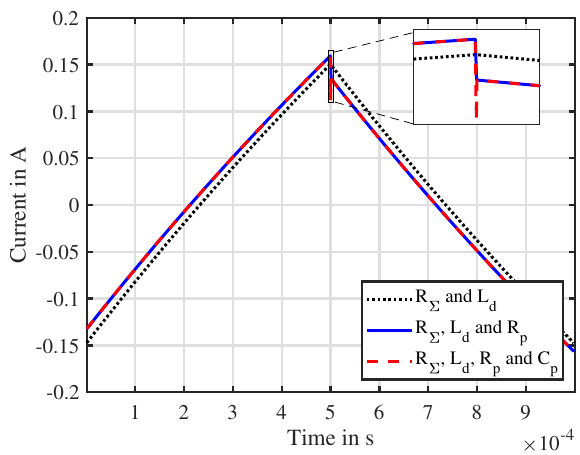
Figure 3. Simulated current inside the actuator in case of an overdamped system: R Σ = 10 Ω , L = 20 mH,